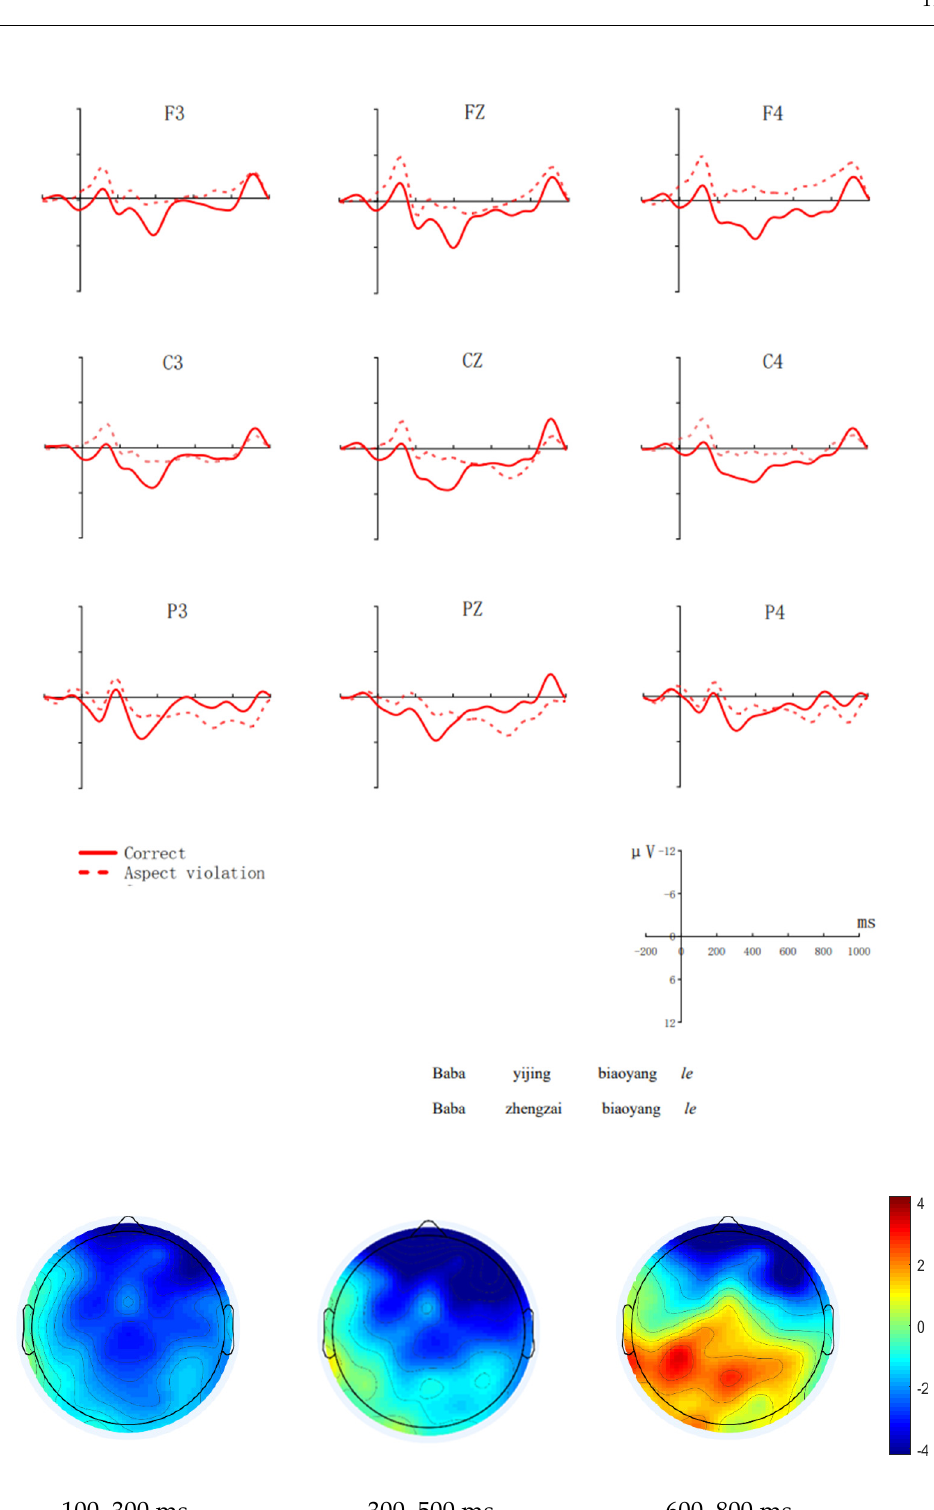
Figure 1. Grand average (N = 20, with 20 valid samples) ERPs of the native speaker group at 9 exemplar electrodes time-locked to the onset (0 ms) of the aspect marker “ le ” as a function of aspect agreement. The x -axis represents the duration, and each hash mark represents 200 ms. The y -axis represents the voltage, which ranged from − 12 to +12 µ V. Negativity is plotted upward. ELAN, LAN-like component and P600 effect’s scalp distribution are depicted in the topographic maps. The topographical voltage map represents the difference waves effects (the aspect violation condition minus the correct condition) at 100–300 ms, 300–500 ms, and 600–800 ms,